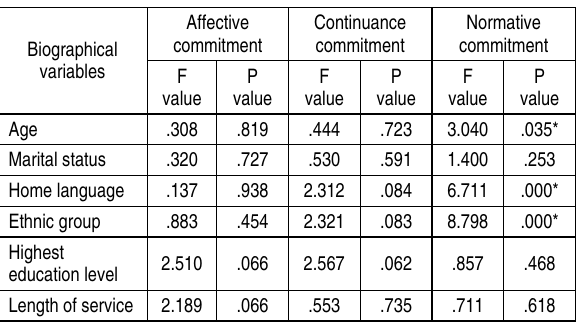
Table 6. ANOVA: biographical variables